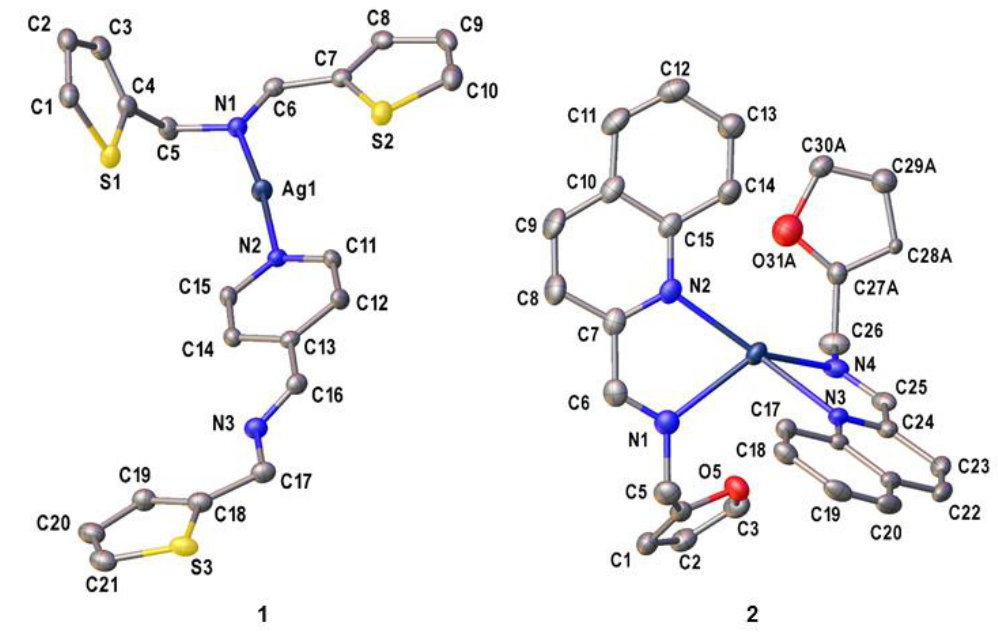
Table 1. Selected geometric parameters for complexes 1 and 2.